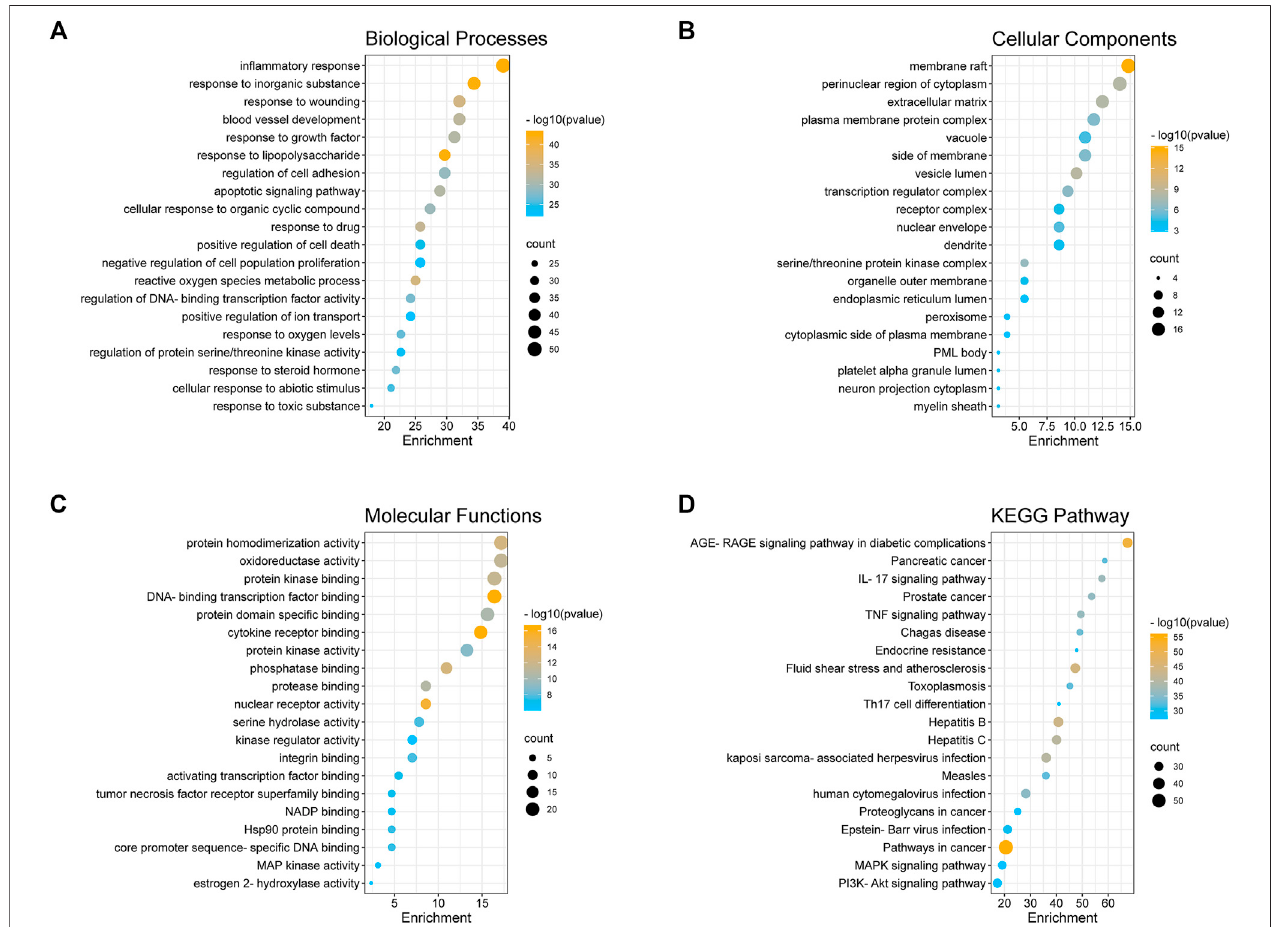
FIGURE 2 | GO enrichment and KEGG pathway analysis of the anti-pneumonia targets of XBS. (A) Biological Processes, (B) Cellular Components, and (C) Molecular Function, (D) KEGG Pathway.